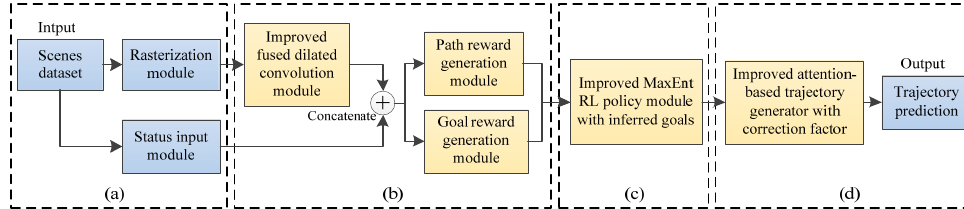
Figure 5. Architecture of the improved multimodal trajectory prediction method. ( a ) Rasterization for the traffic scene; ( b ) Reward initialization based on a two-stage backbone; ( c ) Reward updating based on the MaxEnt RL policy; ( d ) Trajectory generation based on the attention mechanism.